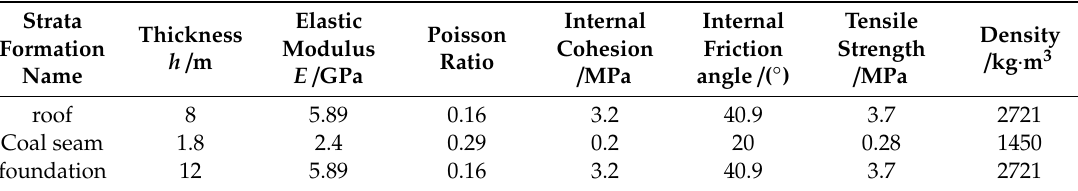
Table 2. Mechanical parameters of each rock stratum.